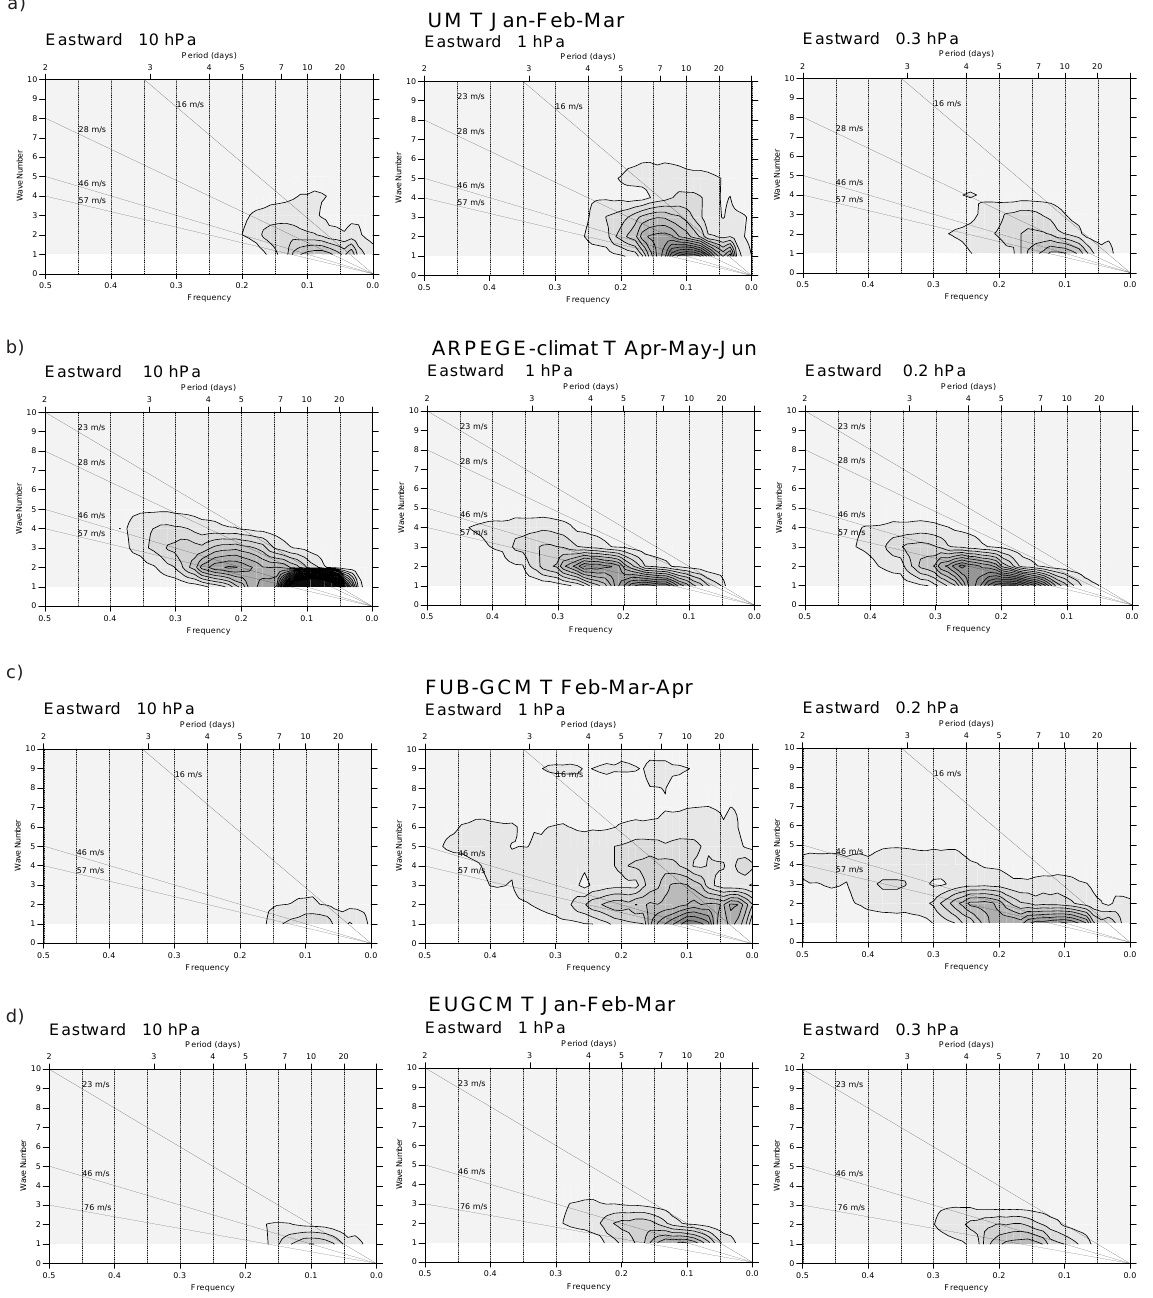
Fig. 7. Frequency-wavenumber power spectrum of the temperature field of the 4 models over an equatorial band. (a) UM model for the time Fig.7 period Jan-Mar at 10 hPa, 1 hPa and 0.3 hPa, (b) ARPEGE-climat model for the time period Apr-Jun at 10 hPa and 1 hPa and 0.2 hPa, (c) FUB-GCM for the time period Feb-Apr at 10 hPa, 1 hPa and 0.2 hPa, (d) EUGCM model for the time period Jan-Mar at 10 hPa, 1 hPa and 0.3 hPa. The contour interval is 1 K 2 day. Solid lines are theoretical dispersion curves corresponding to different Kelvin waves phase speeds relative to the ground. The power spectrum is defined as in Fig.